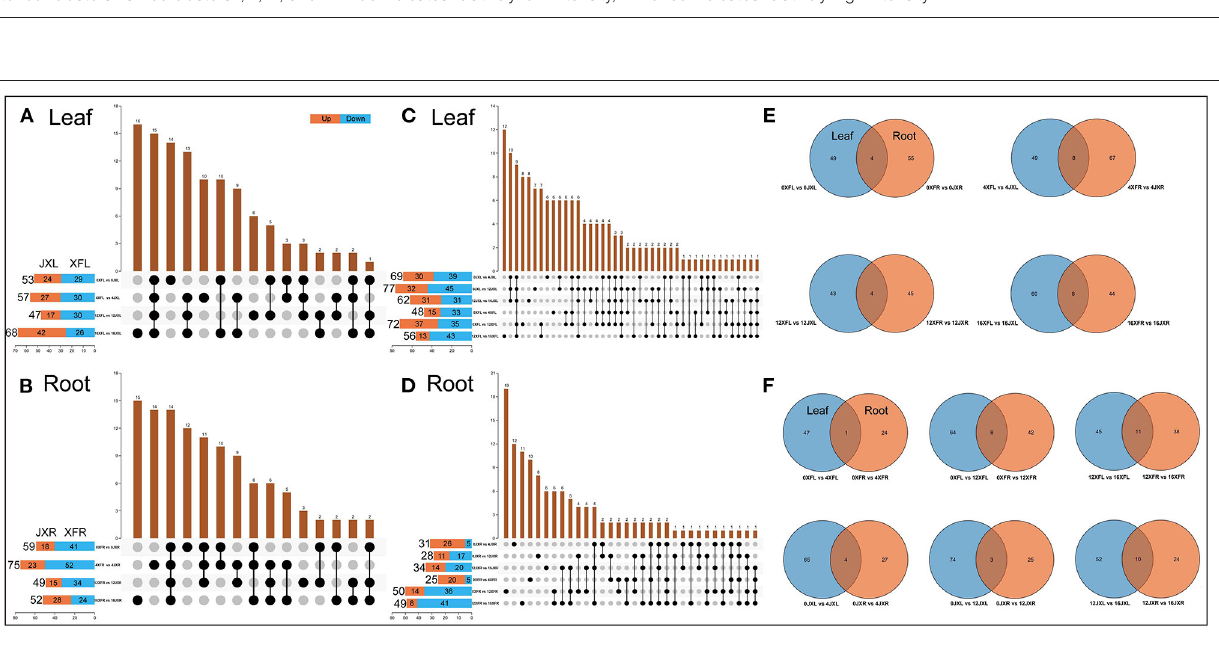
Frontiers in Plant Science |